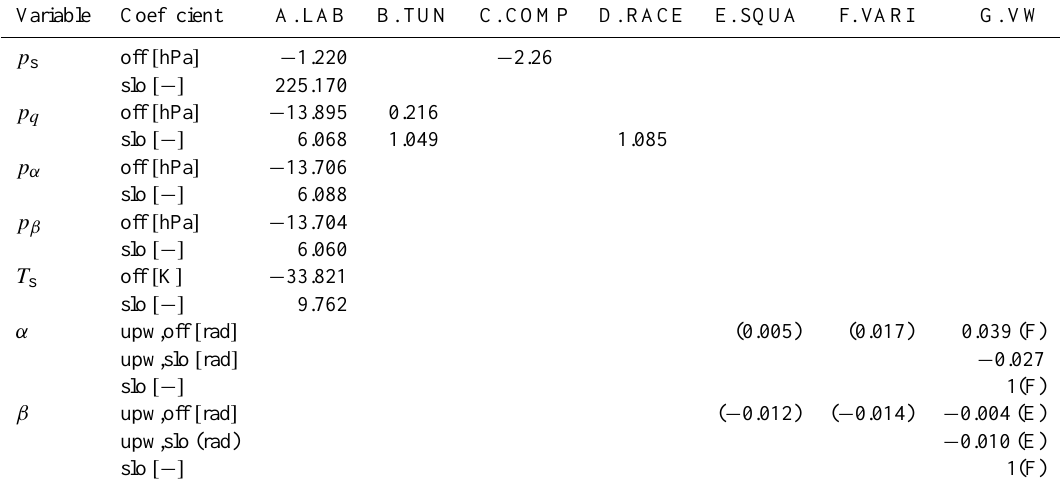
Table 6. Coefficients for static pressure ( p s ), dynamic pressure ( p q ), differential pressures ( p α , p β ), static temperature ( T s ), and flow angle measurements ( α , β ) during calibration steps A–G. Respective environments are laboratory (LAB), wind tunnel (TUN), comparison to ground based measurements (COMP), racetrack (RACE), wind square (SQUA), variance optimization (VARI) and vertical wind (VW) specific flight patterns. Coefficients are distinguished in offset (off) and slopes (slo), where applicable with lift coefficient in the upwash corrections (upw). Cross-calibration is referred to with the calibration steps in parentheses. Coefficients in parentheses were only used for intermediate